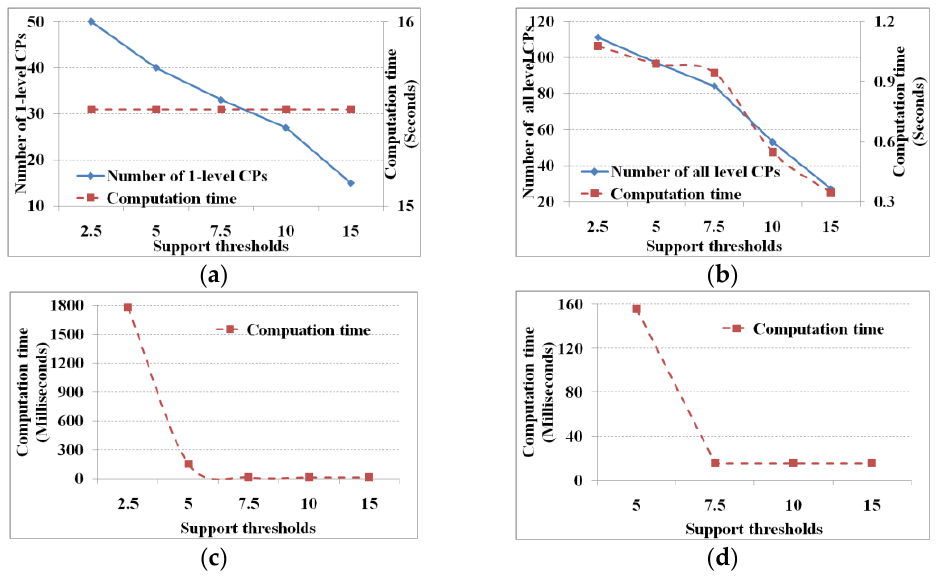
Figure 4. Performance under different support thresholds. ( a ) Number of one-level cascading patterns and computation time; ( b ) Total number of cascading patterns and computation time; ( c ) Computation time of linking and pruning; ( d ) Partial enlargement of ( c ).